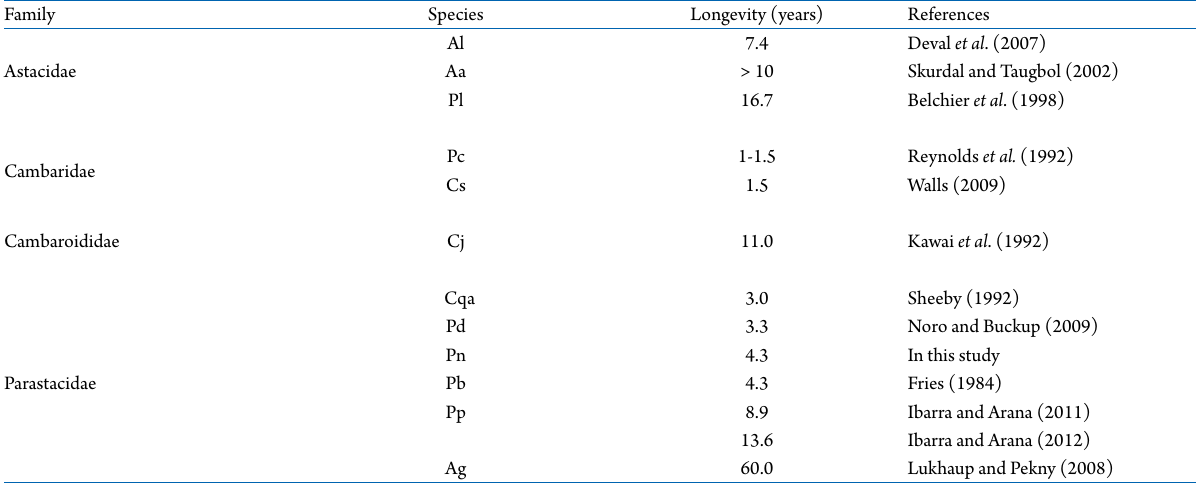
Table 4. Longevity of some crayfish